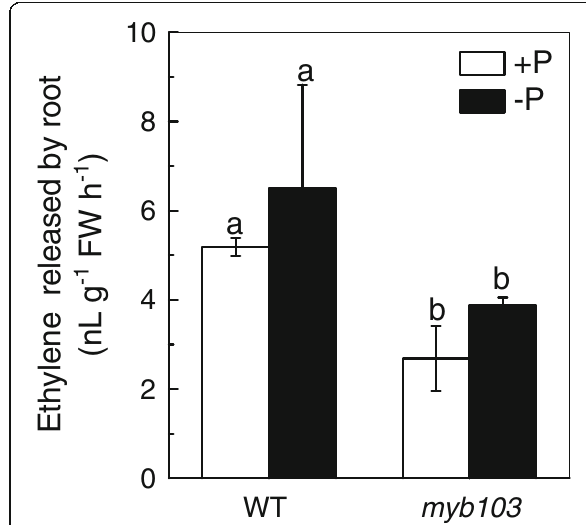
Fig. 7 Ethylene production in WT and myb103 roots. After seedlings were hydroponically treated with +P or -P solution for 7 d, the production of the ethylene was measured in a gas chromatograph. Values are means ± SD, n = 4. Different letters on the bars indicate significant differences at p <